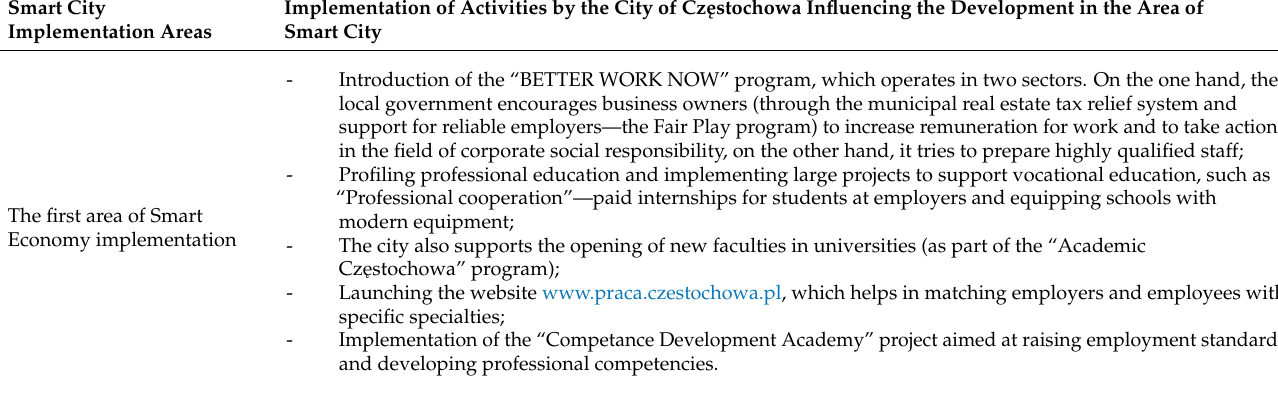
Table A1. Implementation of activities by the City of Cz˛estochowa related to the areas of smart